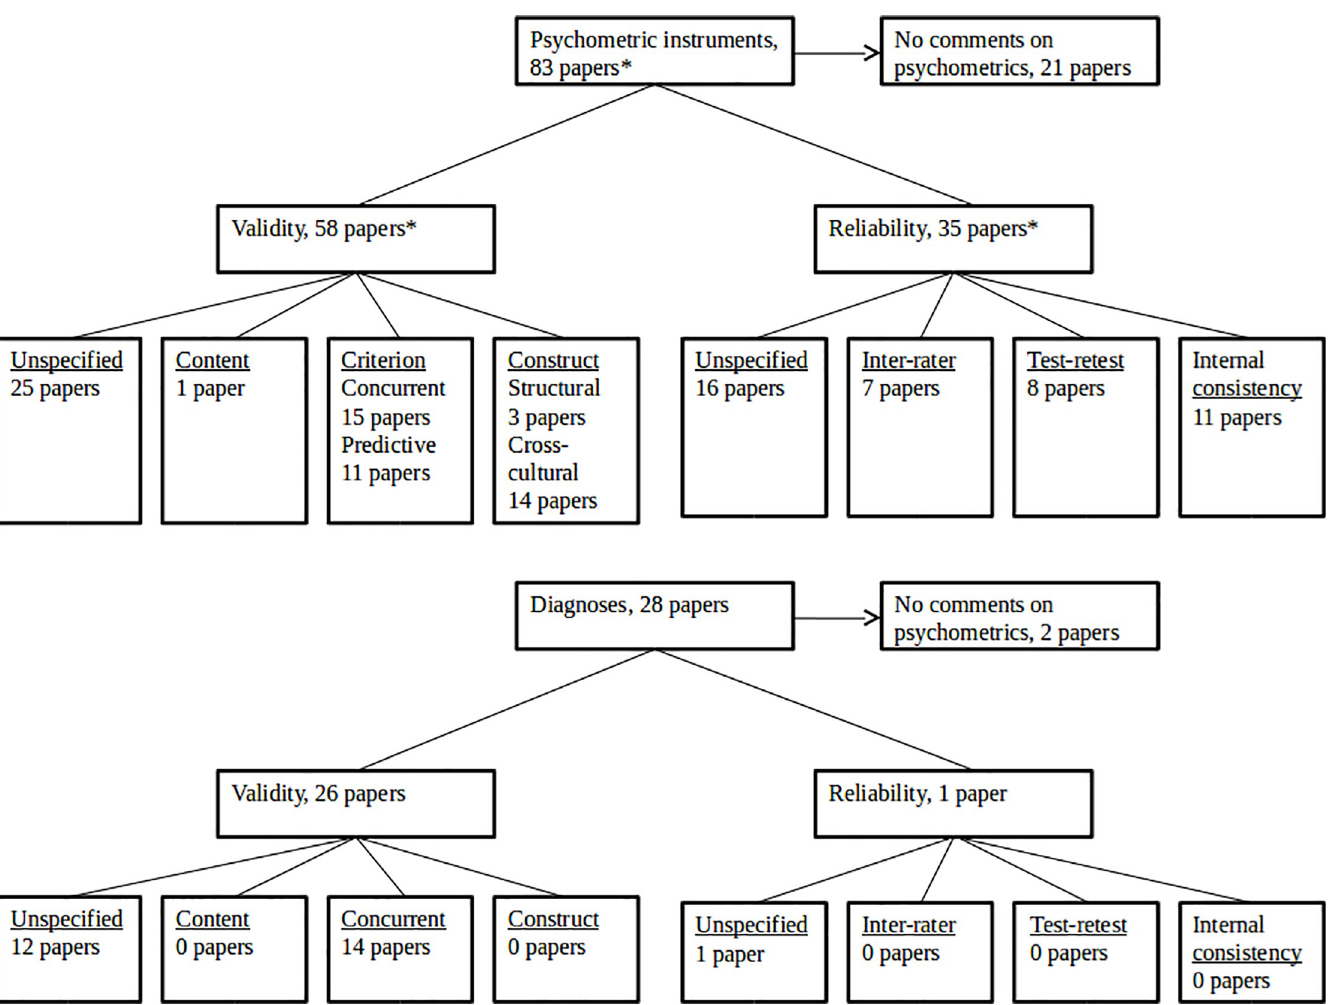
Fig 4. Psychometric properties of the neurodevelopment outcome measure mentioned in medication safety papers on psychotropics and analgesics. � Some papers commented on both validity and reliability, and those papers that commented on specific types of validity or reliability could comment on more than on type. One study used both diagnoses and psychometric instruments. Therefore the numbers add up to more than the total number of papers.